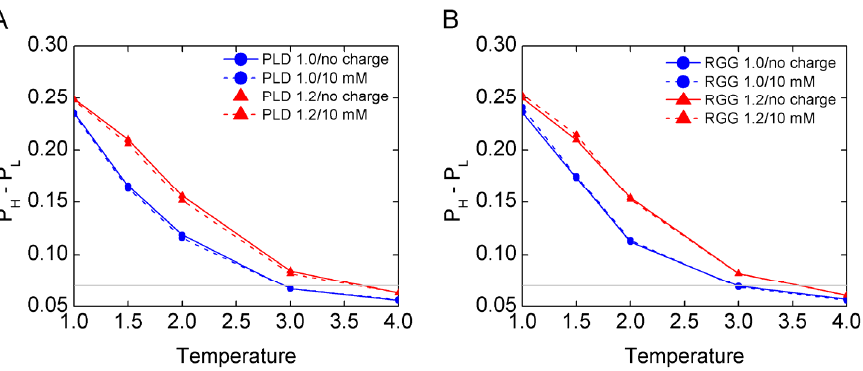
Figure 3. P H − P L of PLD ( A ) and RGG ( B ) with bead mass 1.0 and 1.2 in different solvents changes with temperature. The P H and P L values are calculated with the last 1000 τ simulation data as P H − P L of all the simulations reaches equilibrium after 3000 τ (see Supplementary Materials). The gray line is P H − P L =0.07.